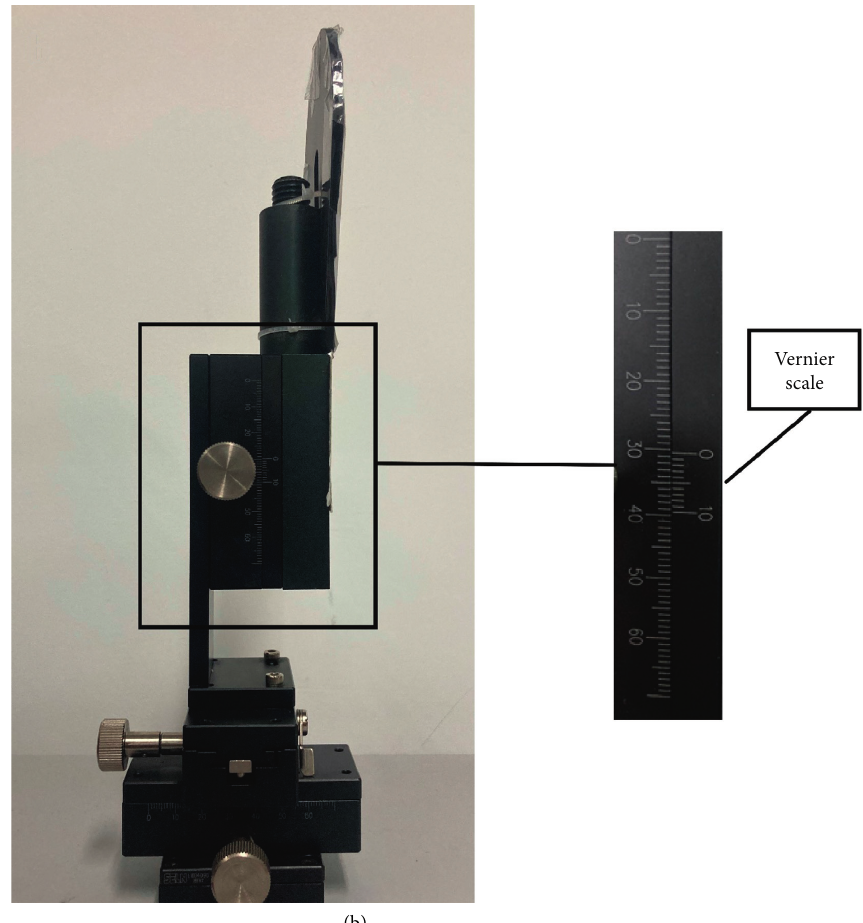
Figure 7: Image monitoring target. (a) Monitoring target. (b) Vernier